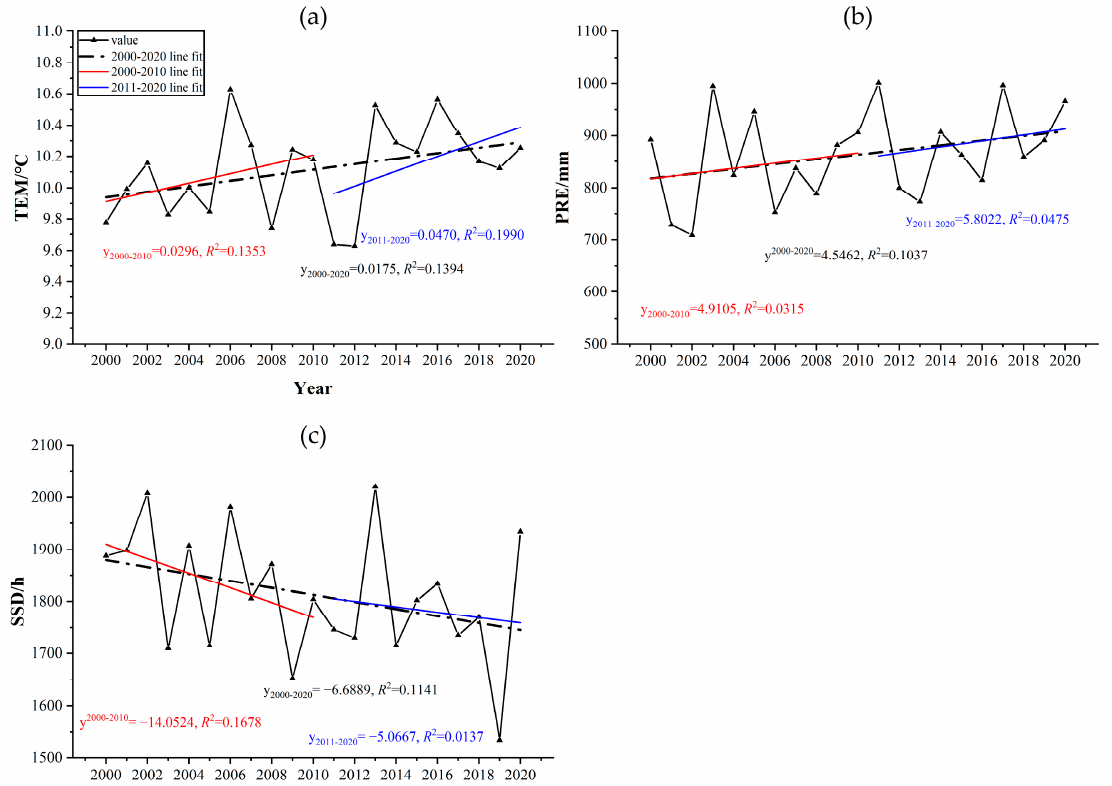
Figure 6. Annual mean change of climate factors in the QBM from 2000–2020: ( a ) TEM ; ( b ) PRE ; ( c ) SSD.